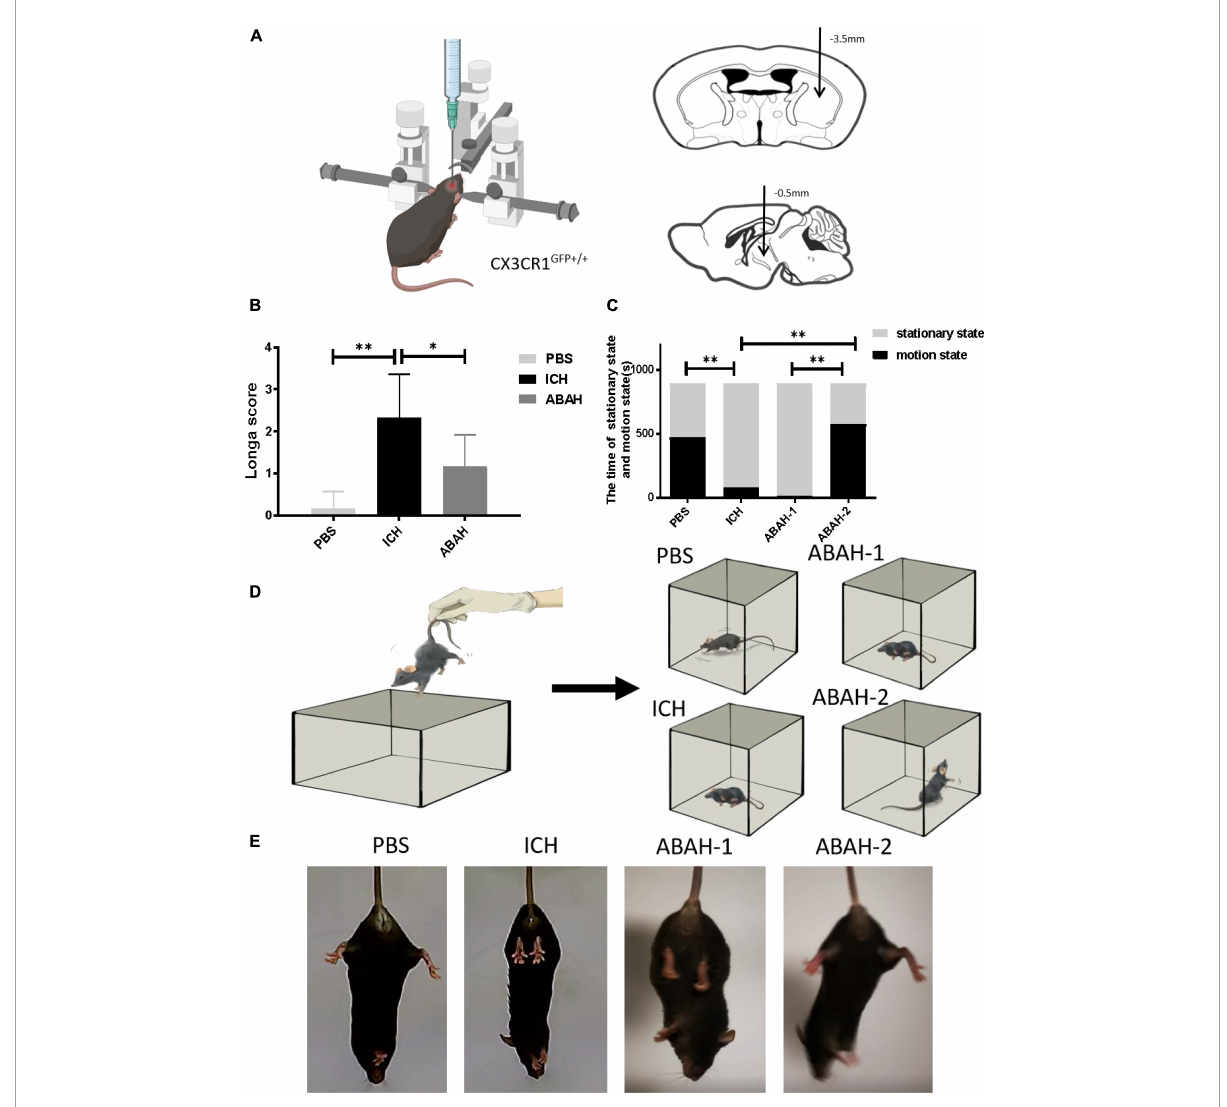
FIGURE1 Inhibition of myeloperoxidase (MPO) activity promotes recovery of motor function following intracerebral hemorrhaging (ICH). (A) Establishment of intracerebral hemorrhage model; (B,C) Longa scores of PBS, ICH, and ABAH groups (* P < 0.05, ** P < 0.01, n = 6 in each group); open field locomotion in the PBS, ICH, and first and second ABAH treatment groups. The times of movement and rest of the mice in the open field were recorded. The total time was 900 s (* P < 0.05, ** P < 0.01, n = 6 in each group); (D) open field mode diagram; (E) hind-limb clasping test in the PBS, ICH, and first and second ABAH treatment groups. The degrees of hind-limb opening and closing in mice were